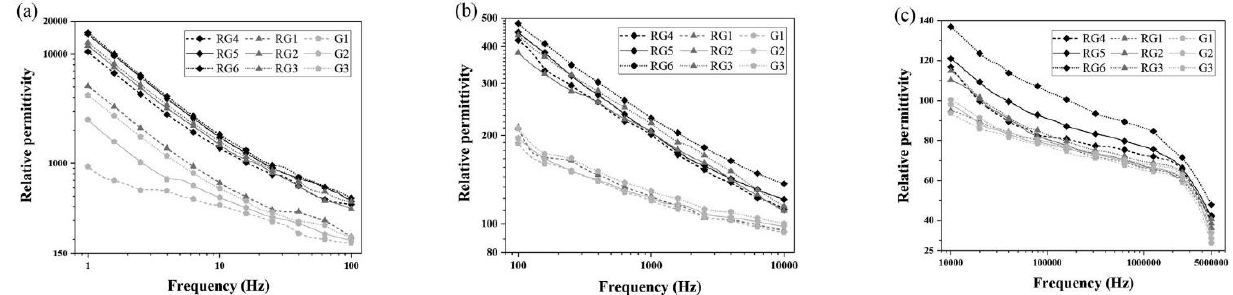
Figure 31. Relative permittivity of cement composites with different GO concentrations within different frequency ranges